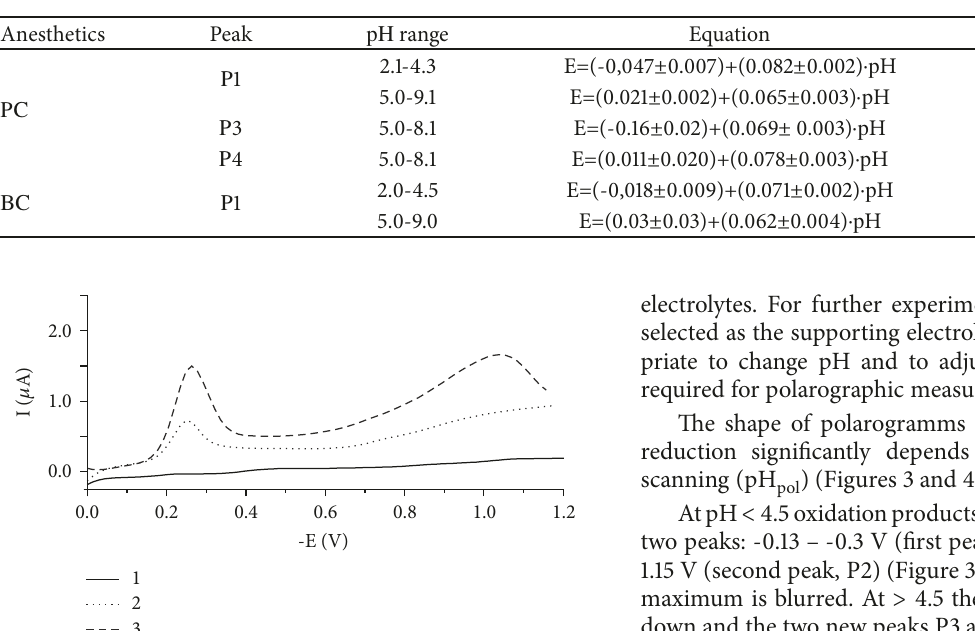
Table 2: The equations of linear dependence of E, V on pH on a phosphate buffer.